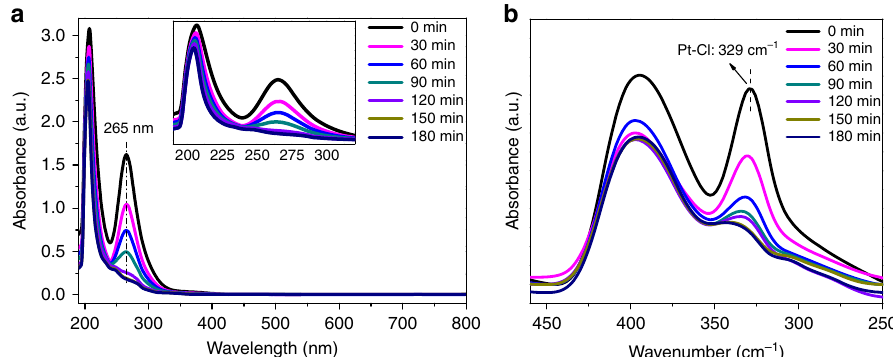
Fig. 1 The reduction of H 2 PtCl 6 . a Ultraviolet (UV) – visible (Vis) spectra of H 2 PtCl 6 during the ethanol reduction process. b Far infrared spectra in the process of H 2 PtCl 6